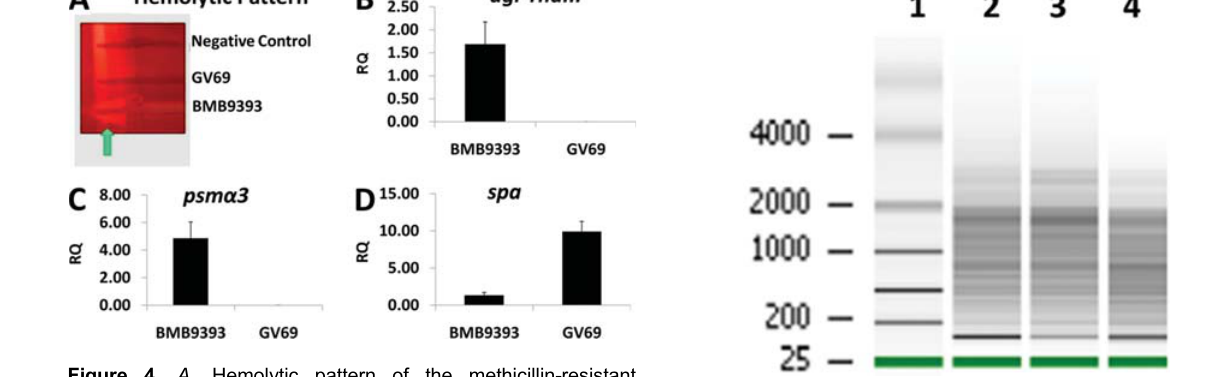
Figure 5. Gel image from the Agilent 2100 Bioanalyzer of enriched mRNA preparation. Lane 1 , ladder; lanes 2 – 4 , enriched mRNA preparation that was obtained from sessile cells of the BMB9393 isolate using total RNA from the optimized